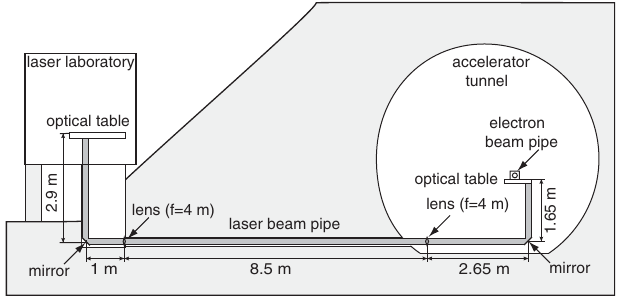
FIG. 6. Schematic cross section of the EO laser laboratory and the FLASH accelerator